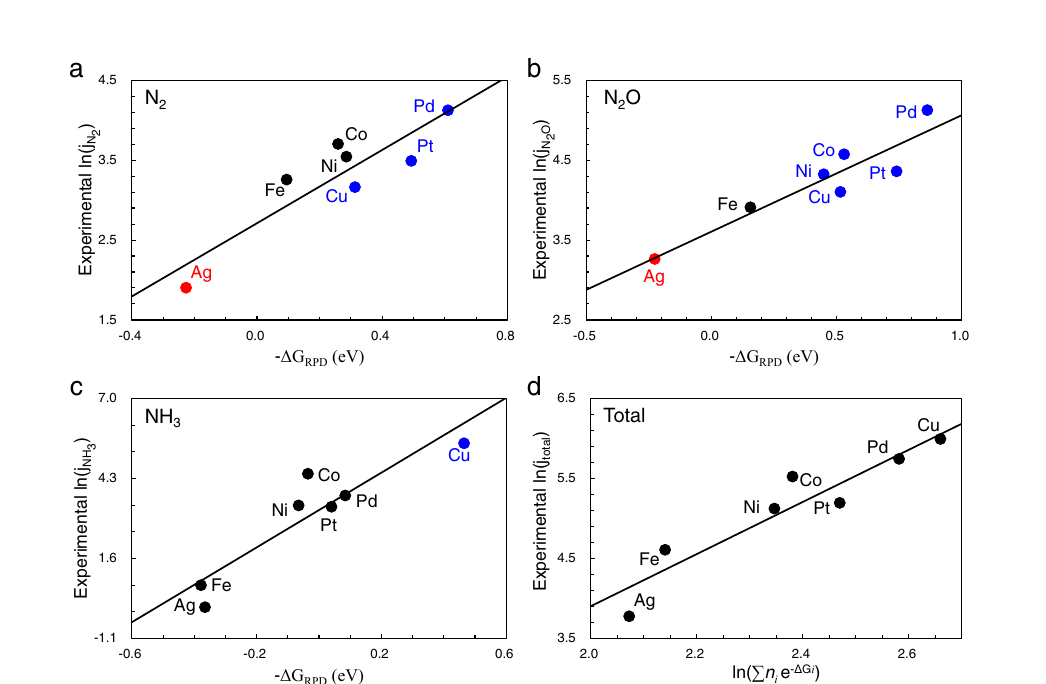
Fig. 3 | The two-dimensional reaction phase diagrams (2D-RPDs). a – d 2D-RPD foreNORRtowards( a )N 2 ,( b )N 2 O,( c )NH 3 ,and( d )NH 2 OHat0Vvs.RHE,wherethe windows with different mechanismsaredividedby gray dotted lines(seedetails in